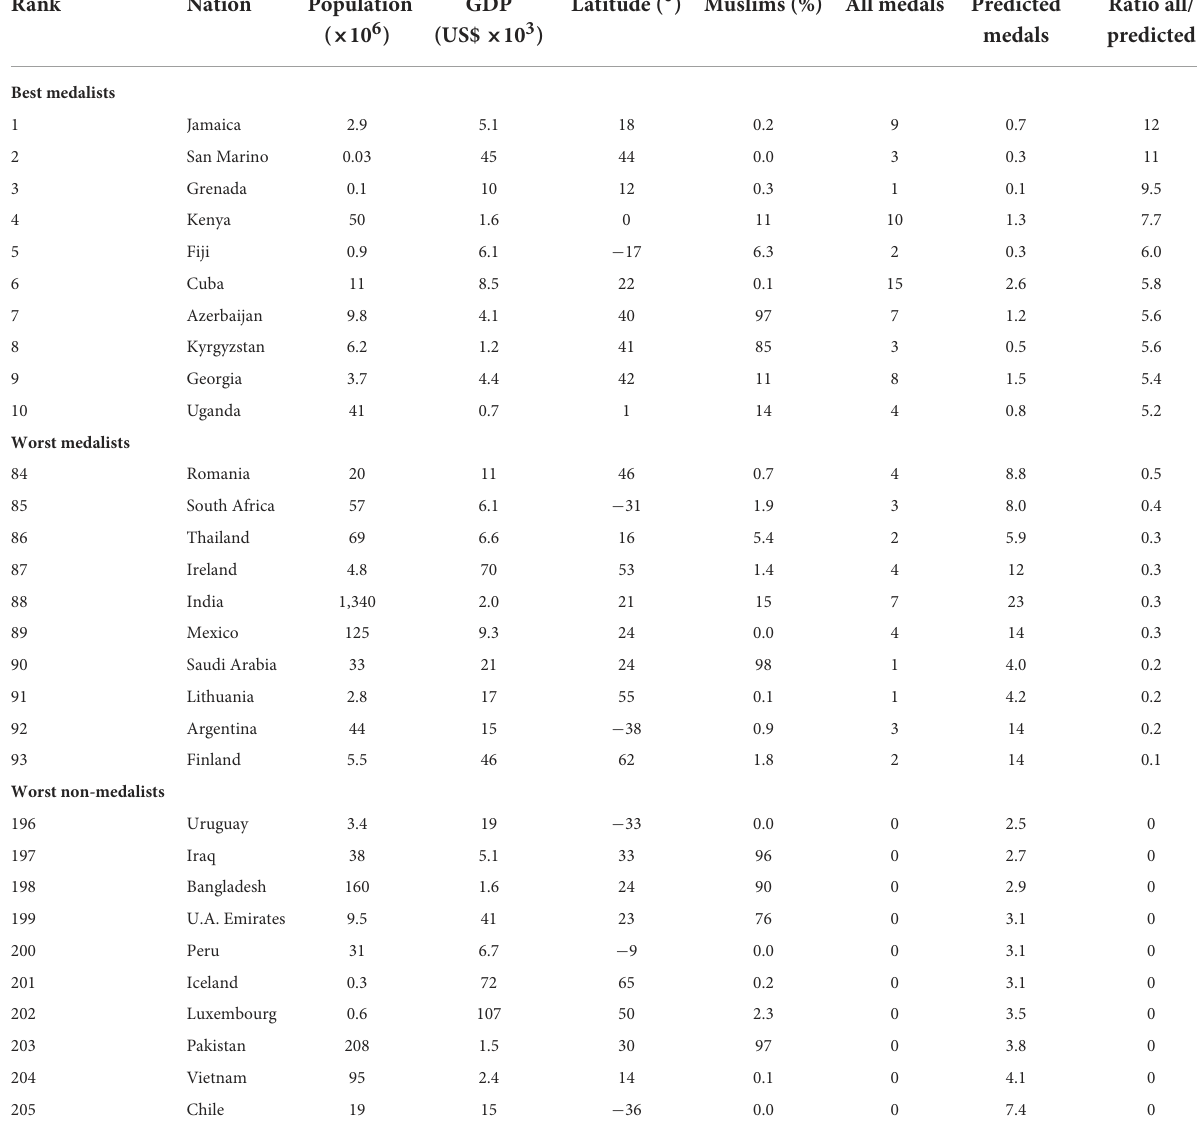
TABLE 5 Ranking of the best medalists, worst medalists and worst non-medalists at the Tokyo summer Olympics. Rank Nation Population Latitude ( ◦ ) Muslims (%) All medals Predicted ( × 10 6 )